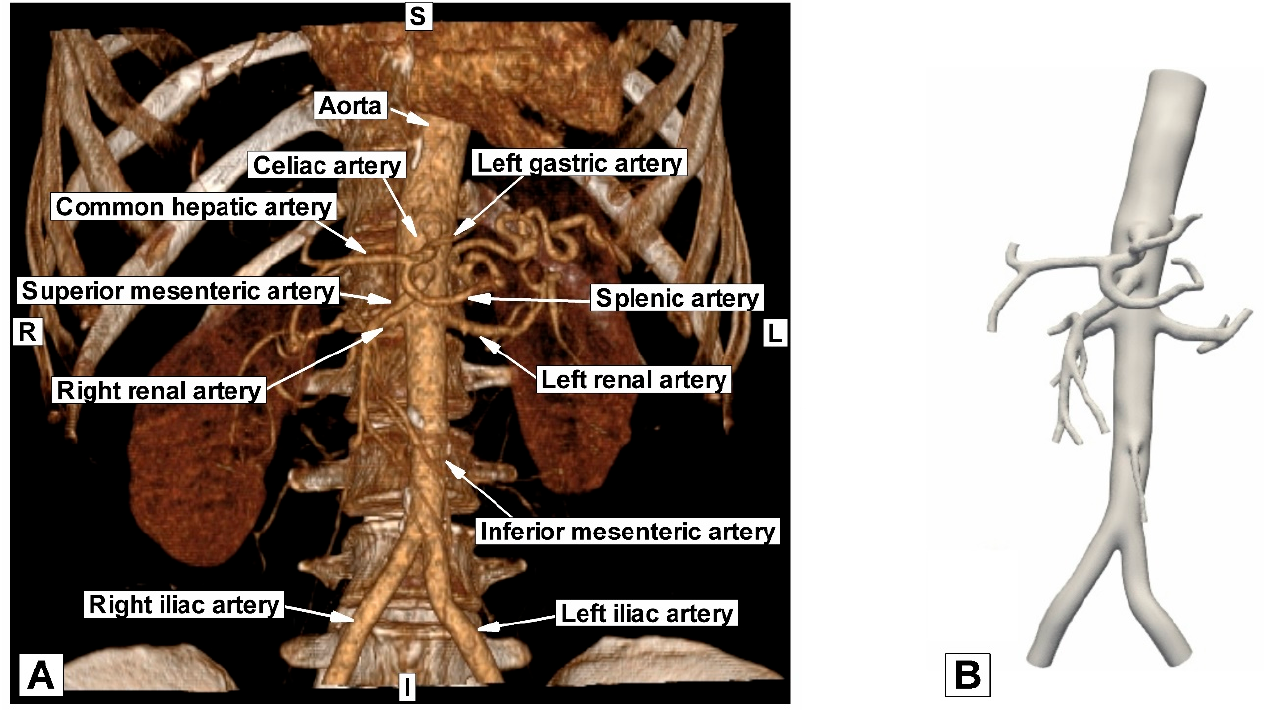
Figure 2. Comparison between geometry reconstruction using ( A ) 3D VRT (volume rendered tech- nique) based on CTA images; and ( B ) advanced numerical techniques.